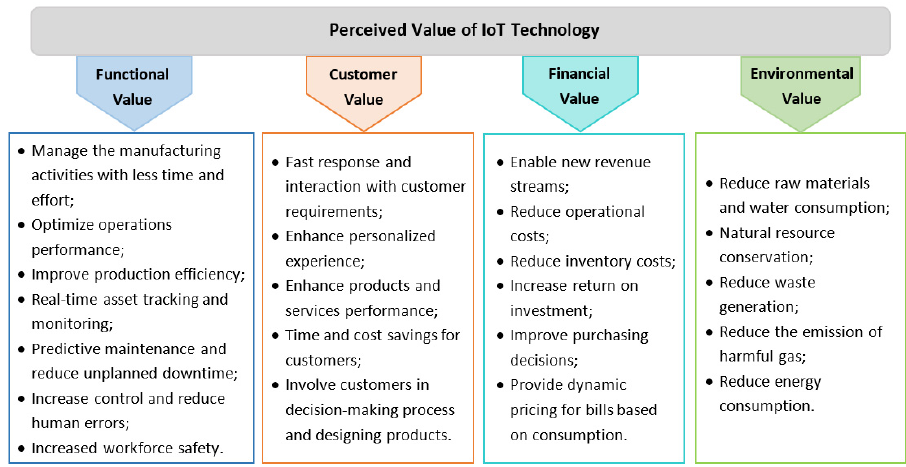
Figure 1. Perceived Value of IoT Technology.